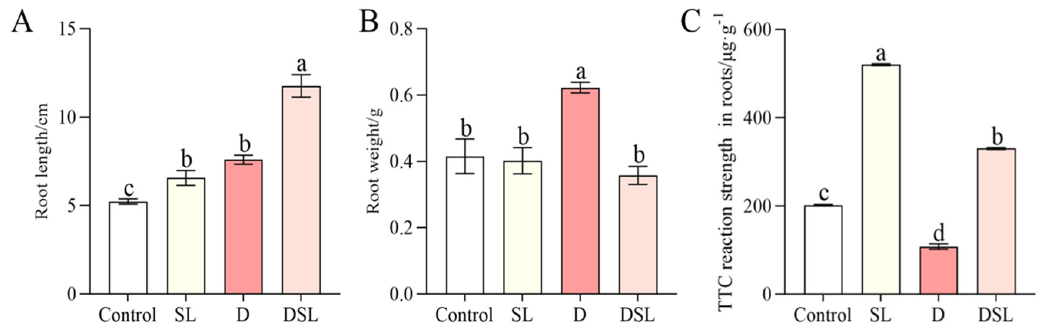
Figure 1. Morphological changes in alfalfa root in response to different treatments include root length ( A ), root weight ( B ), and TTC ( C ). Results are presented as the mean of four independent experiments ± standard error. a − d Different superscripts mark significant differences between the treatments ( p < 0.05).